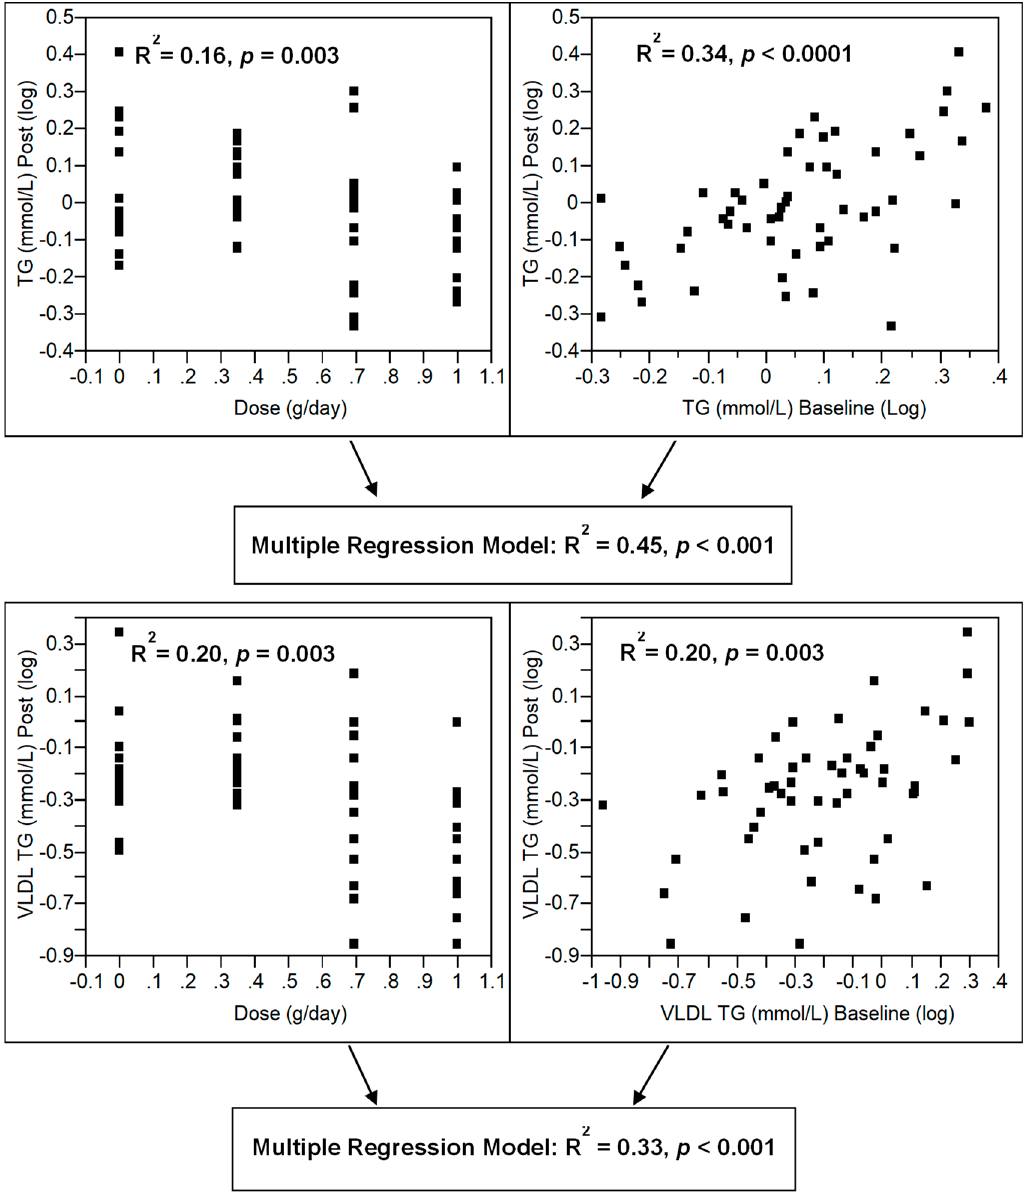
Figure 4. Multiple regression models for the combined effects of n -3 LCPUFA dose and baseline levels of plasma and very-low-density lipoprotein (VLDL) triglyceride levels in pre-menopausal women supplementation with 0, 0.35, 0.7, and 1 g/day n -3 LCPUFA from HiDHA™ tuna oil ( n = 53). 0 g/day group n = 12; 0.35 g/day group n = 15; 0.7 g/day group n = 13; 1.0 g/day group n = 13.